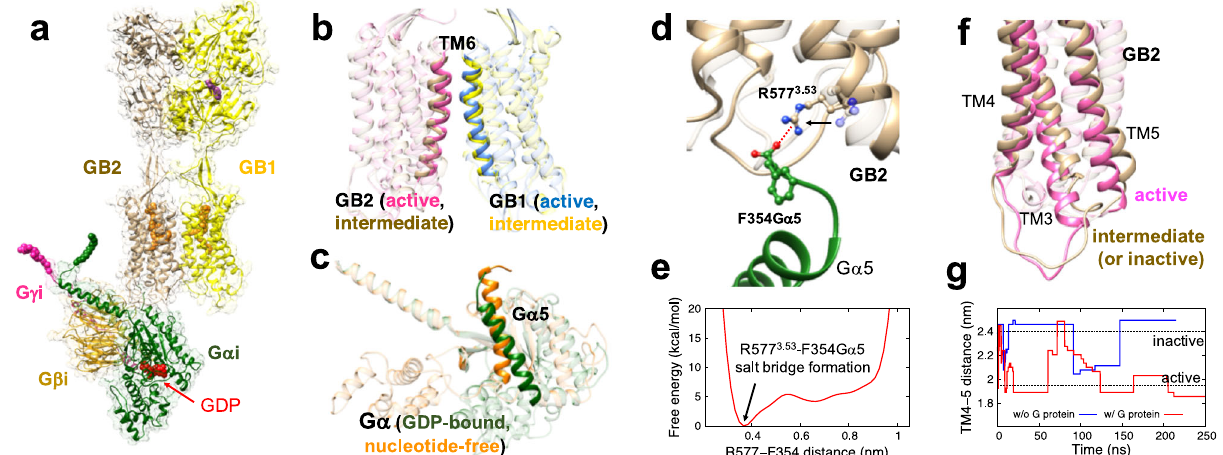
Fig. 3 | The pre-activated agonist-GABA B R-G i P complex structure. a The pre- activated structure is composed of GDP-bound inactive G i P and GABA B R in an intermediatestatewith theagonistbound to GB1-VFTbut without PAM. b The pre- activatedstateofGABA B RhastheactiveTM6-TM6interfacebutnoPAMinbetween TMDs. c The G α 5 helix in the inactive G i P with GDP bound in between Ras-like and AH domains is rotated and translated forward upon the activation. d As G i P approaches the receptor, F354G α 5 forms a SB with GB2-R577 3.53 . Here the trans- parent inactive conformation is superimposed for comparison. e The free energy